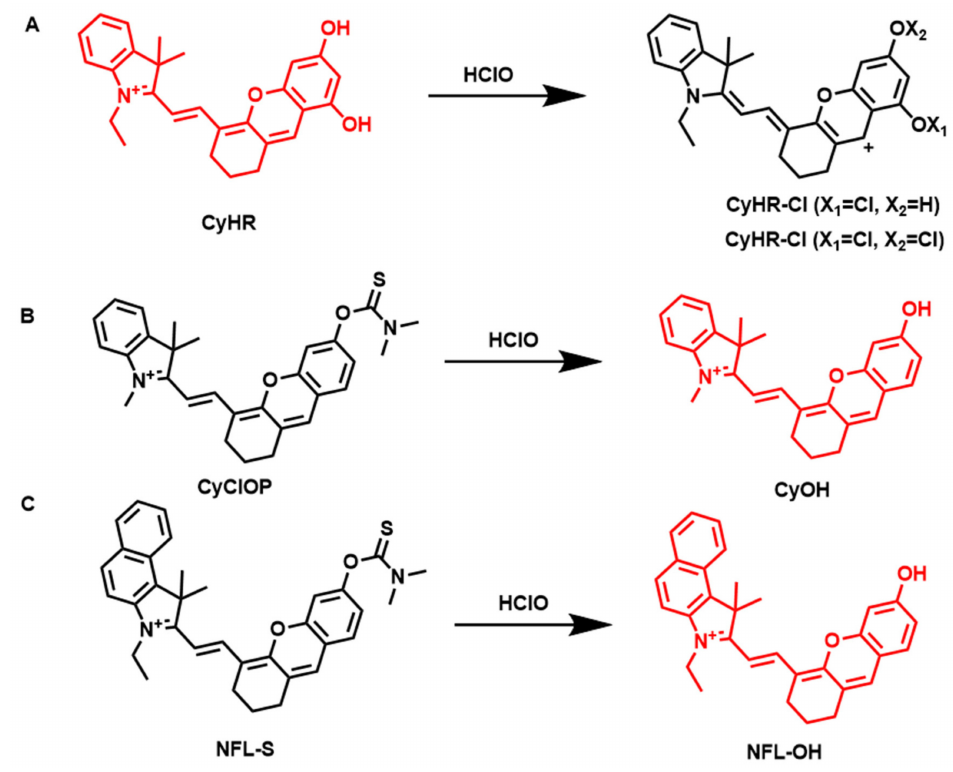
Figure 7. The responsive mechanisms and chemical structures ( A ) CyHR, ( B ) CyClOP and ( C ) NFL-S of the fluorescent probe for